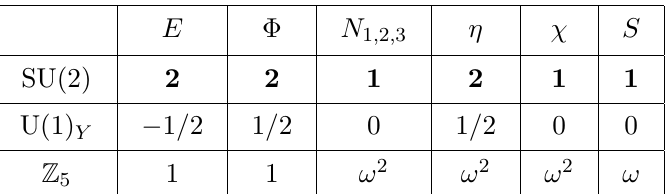
Table 1 . Charge assignments of the fermions and scalars in the (cid:23) SIMP model, where E = the SM lepton doublet, (cid:8) is the SM Higgs doublet, and ! = exp